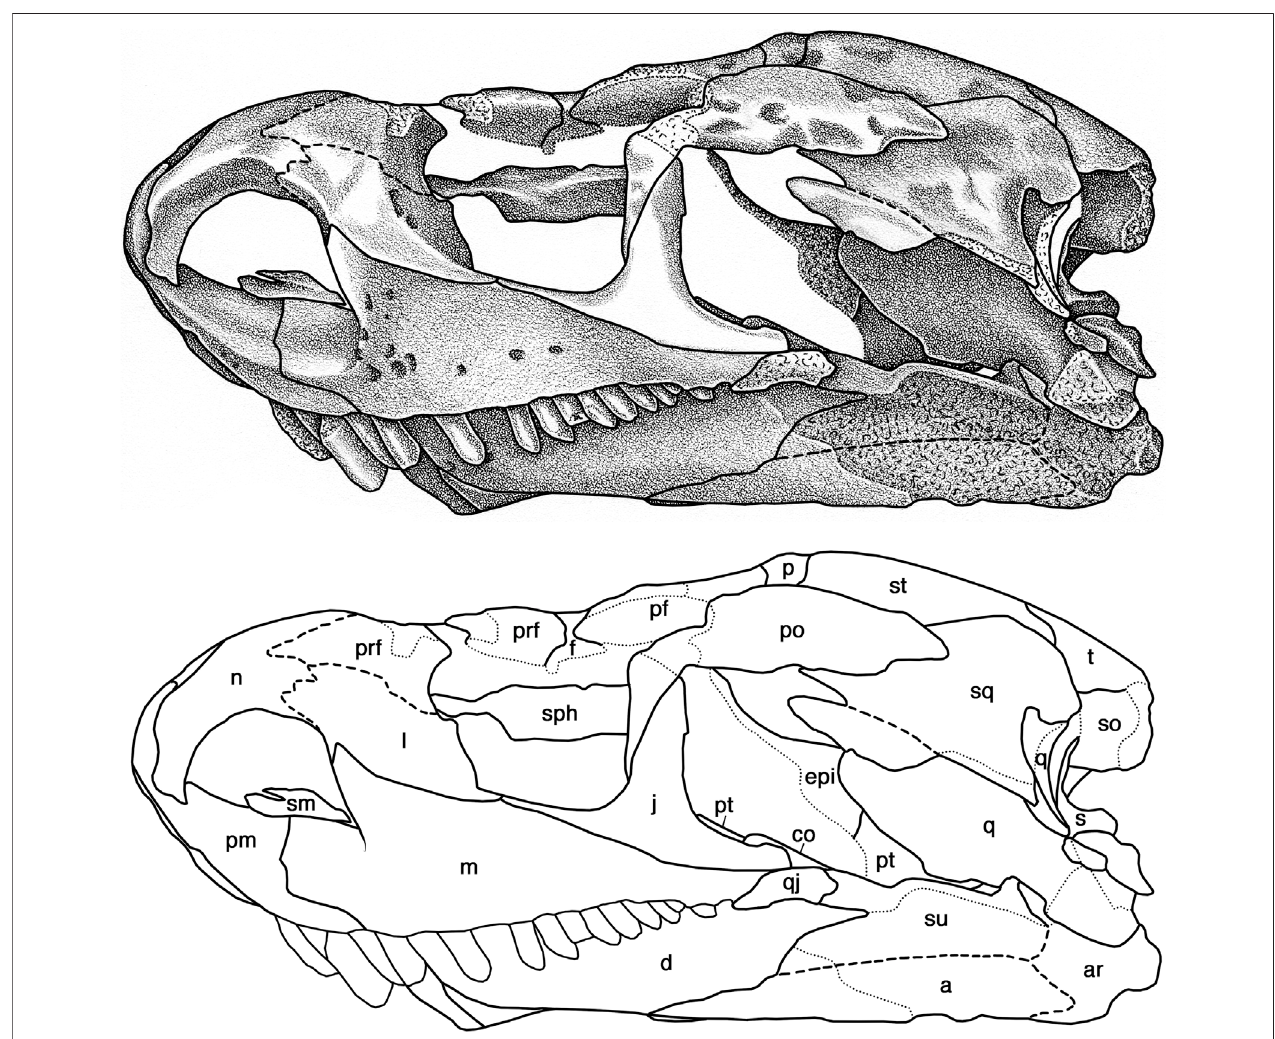
FIGURE 7 | Cotylorhynchus romeri , OMNH 04329, referred specimen. Skull in left lateral view. Abbreviations as in Figure 6 .